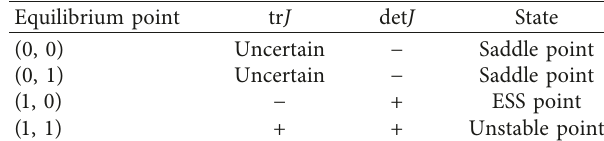
Table 4: Evolutionary stability of local equilibrium points